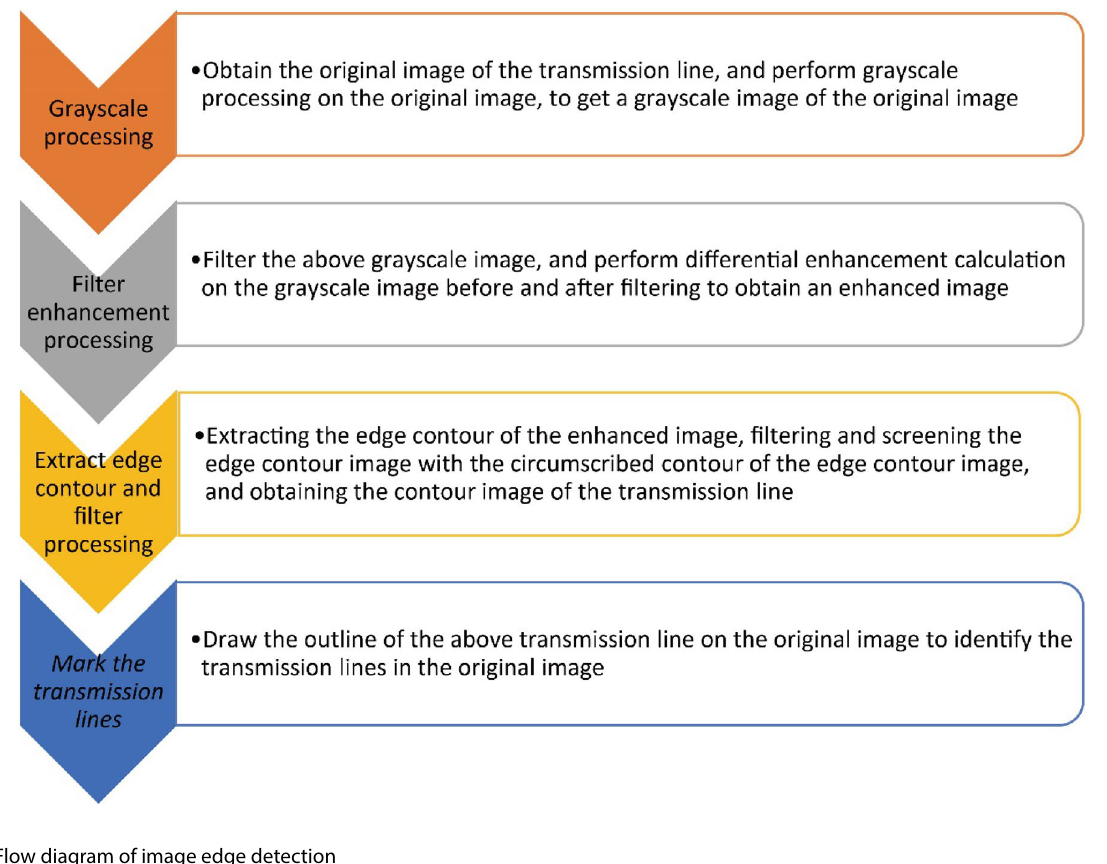
Fig. 3 Flow diagram of image edge detection